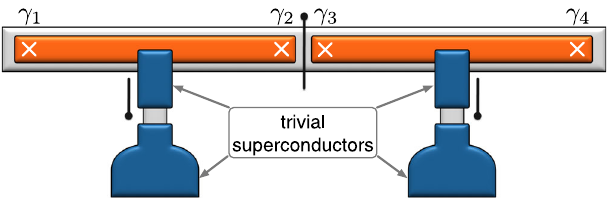
FIG. 4. Alternative two-island setup involving trivial super- conducting wires forming gate-tunable Josephson junctions with conventional bulk superconductors. This shunt-junction configu- ration is expected to more efficiently quench the island charging energy in the open-valve configuration shown here. Indeed, the vertical wires can support N ≫ 1 channels (unlike the horizontal wire hosting Majorana modes), thus enhancing the maximum Josephson energy E J